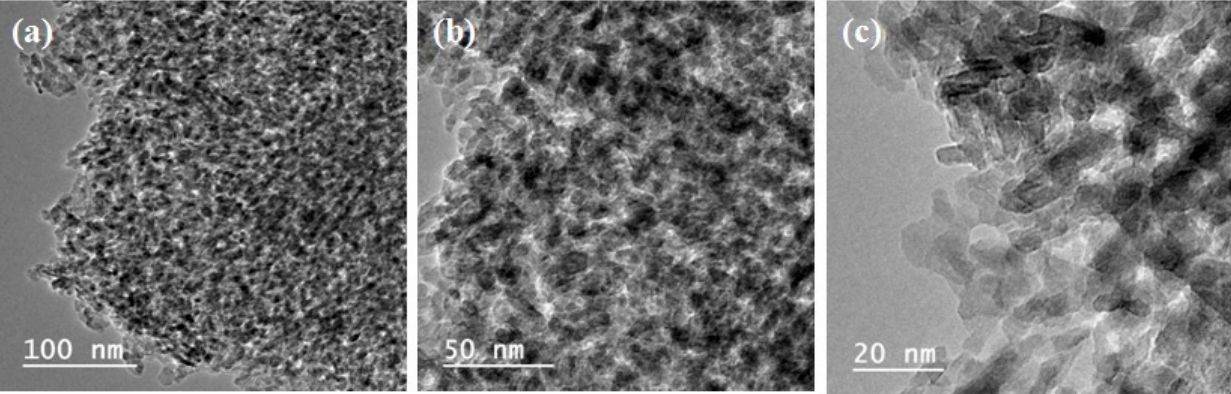
Figure 6. TEM images of Cu-ZSM5 ( a – c ) .